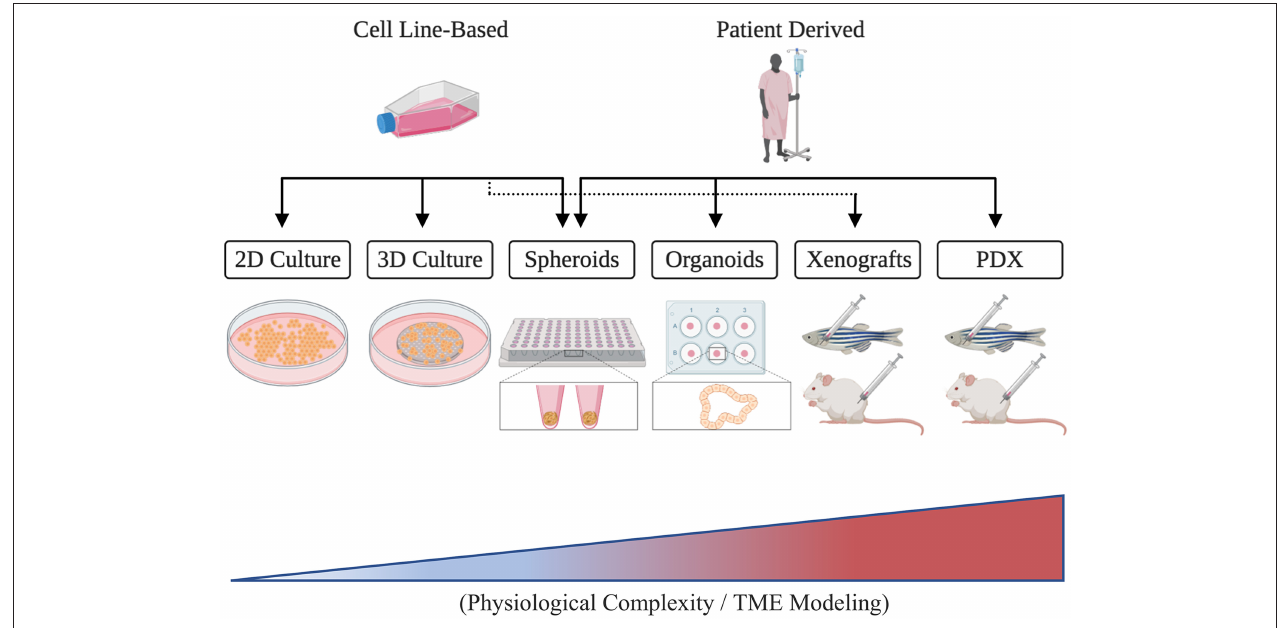
FIGURE 1 | A schematic illustrating different cancer modeling methods in the order of increasing tumor microenvironment (TME) representation.